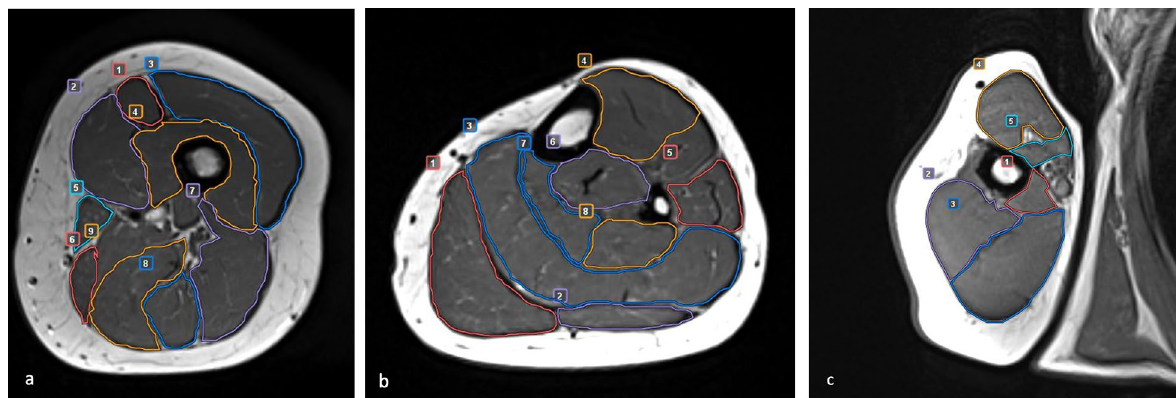
Fig. 1 Axial T1w images showing ROIs of the different anatomical compartments. a 1 rectus femoris, 2 vastus medialis, 3 vastus lateralis, 4 vastus intermedius, 5 sartorius, 6 gracilis, 7 biceps femoris, 8 semitendinosus, 9 semimembranosus. b 1 Medial gastrocnemius, 2 lateral gastrocnemius, 3 soleus, 4 anterior tibialis, 5 peroneal muscles, 6 posterior tibialis, 7 flexor digitorum longus, 8 flexor hallucis longus. c 1 Medial head of triceps brachii, 2 lateral head of triceps brachii, 3 long head of triceps brachii, 4 biceps brachii, and 5 coraco